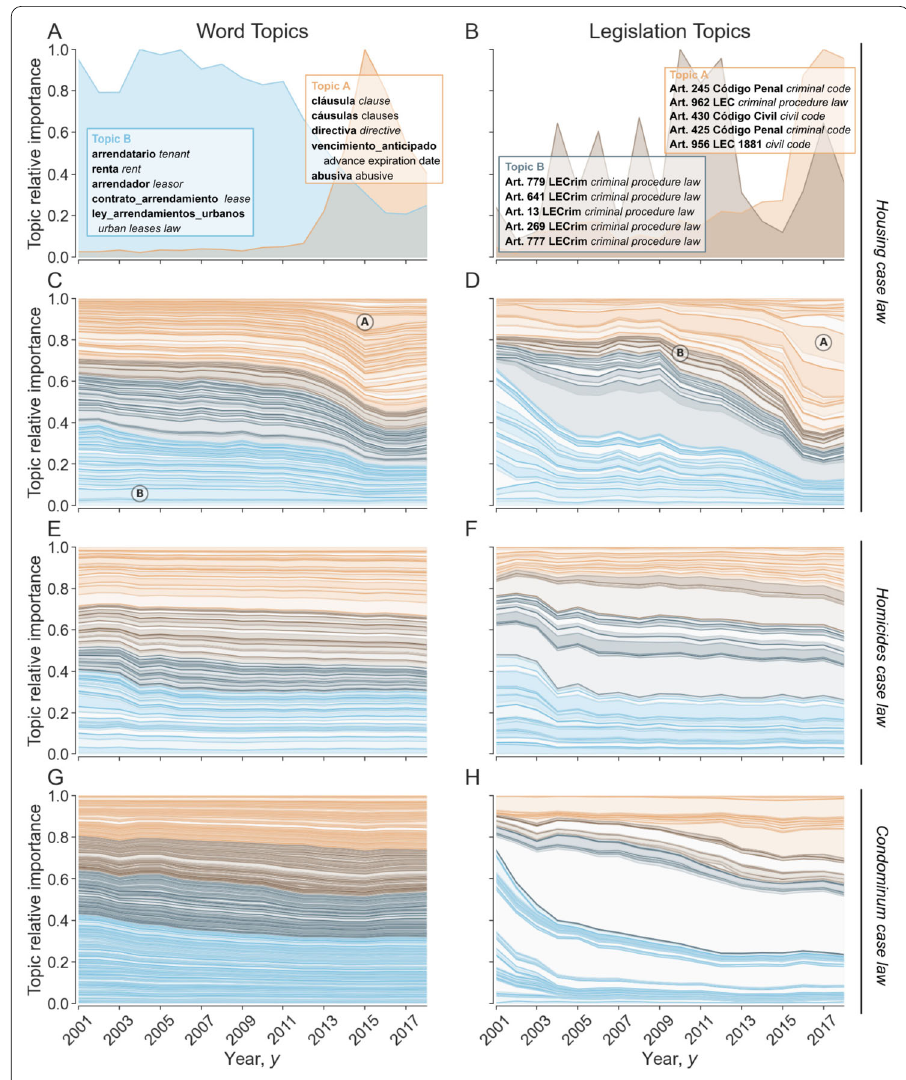
Figure 3 Time evolution of word topics (left column) and legislation topics (right column). For each year y , we compute the topic distribution P ( T | y ) (Section 2). ( A-B ) Time evolution of the importance of some illustrative topics in the housing corpus, normalized by their maximum importance across years (Section 2). While some topics decrease in the period 2012-2018, others show the opposite behavior. Topics depicted in blue reach their maximum importance in early years, whereas orange topics reach their maximum importance in the final years. Topics that reach their maximum importance in intermediate years are depicted in gray. ( C-H ) Evolution of all topics for the three corpora: ( C-D ) housing; ( E-F ) homicides, and ( G-H ) and condominium. Each layer corresponds to a topic and their thickness corresponds to their relative importance in a given year. Topics shown in panels ( A ) and ( B ) are identified in ( C ) and ( D ), respectively. Hierarchical levels: C, L = 2; D, L = 1; E, L = 2; F, L = 0; G, L = 1; H, L = 0; we show the analogous results for other hierarchical levels in the models in Figs. S3 and S4 in Additional file